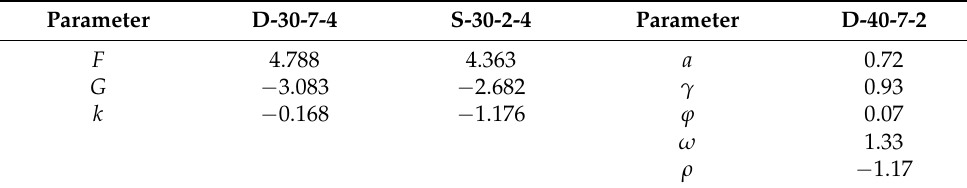
Table 6. Parameters adopted in Figure